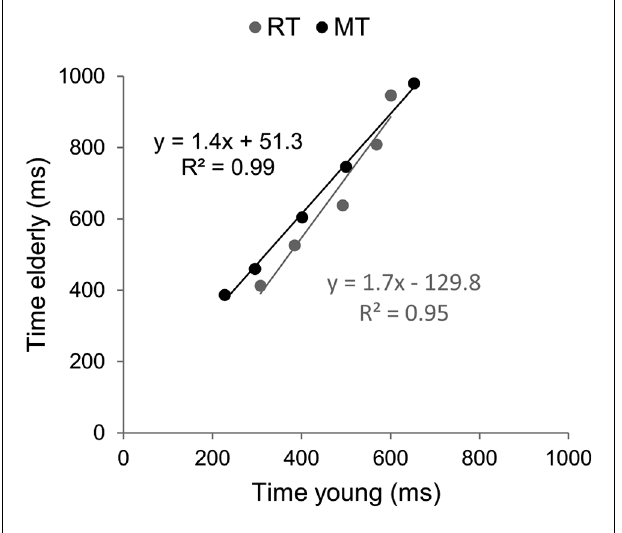
FIGURE 4 | Brinley plots without the hardest ID condition. Data and linear regression estimates of reaction time (observed in Hick–Hyman’s task) are presented in gray and those of movement time (observed in Fitts’ task) are presented in black. Data points correspond to the first four ID conditions of each task,